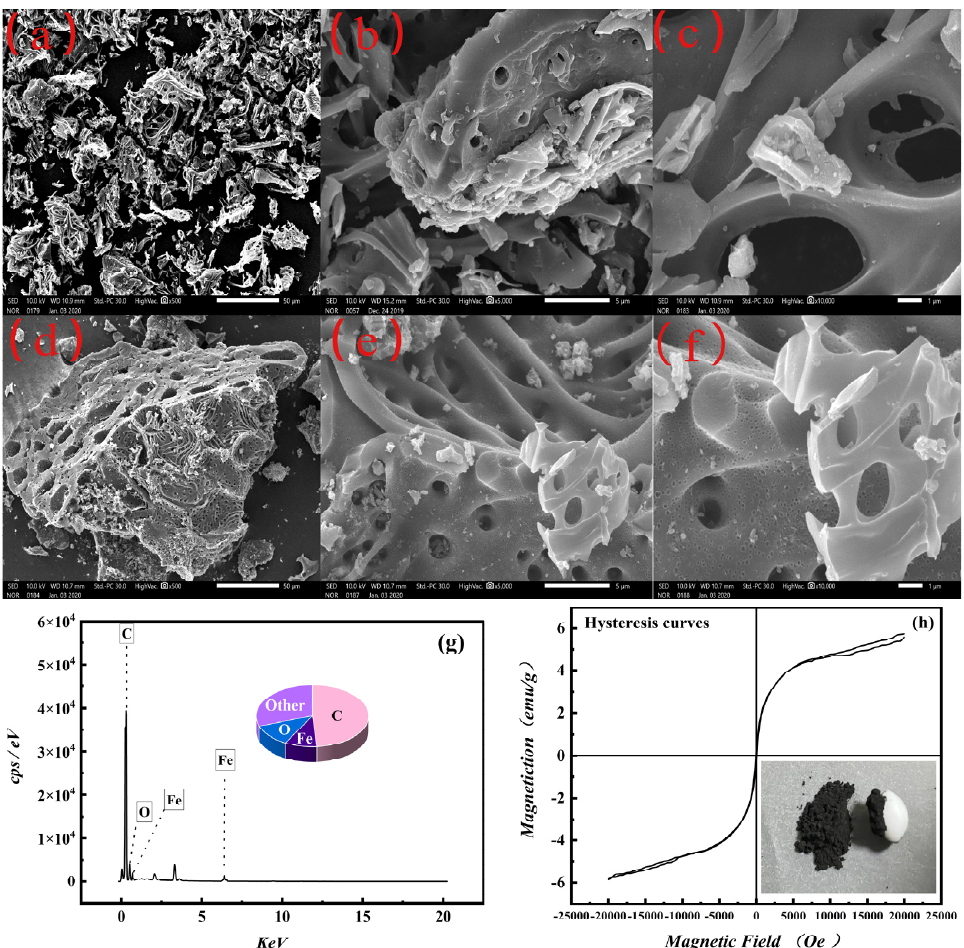
Figure 1. SEM images of BC ( a , b , c ) and Fe 3 O 4 -MOS ( d , e , f ); EDS elemental analysis of Fe 3 O 4 -MOS ( g ); and hysteresis curves of Fe 3 O 4 -MOS ( h ).